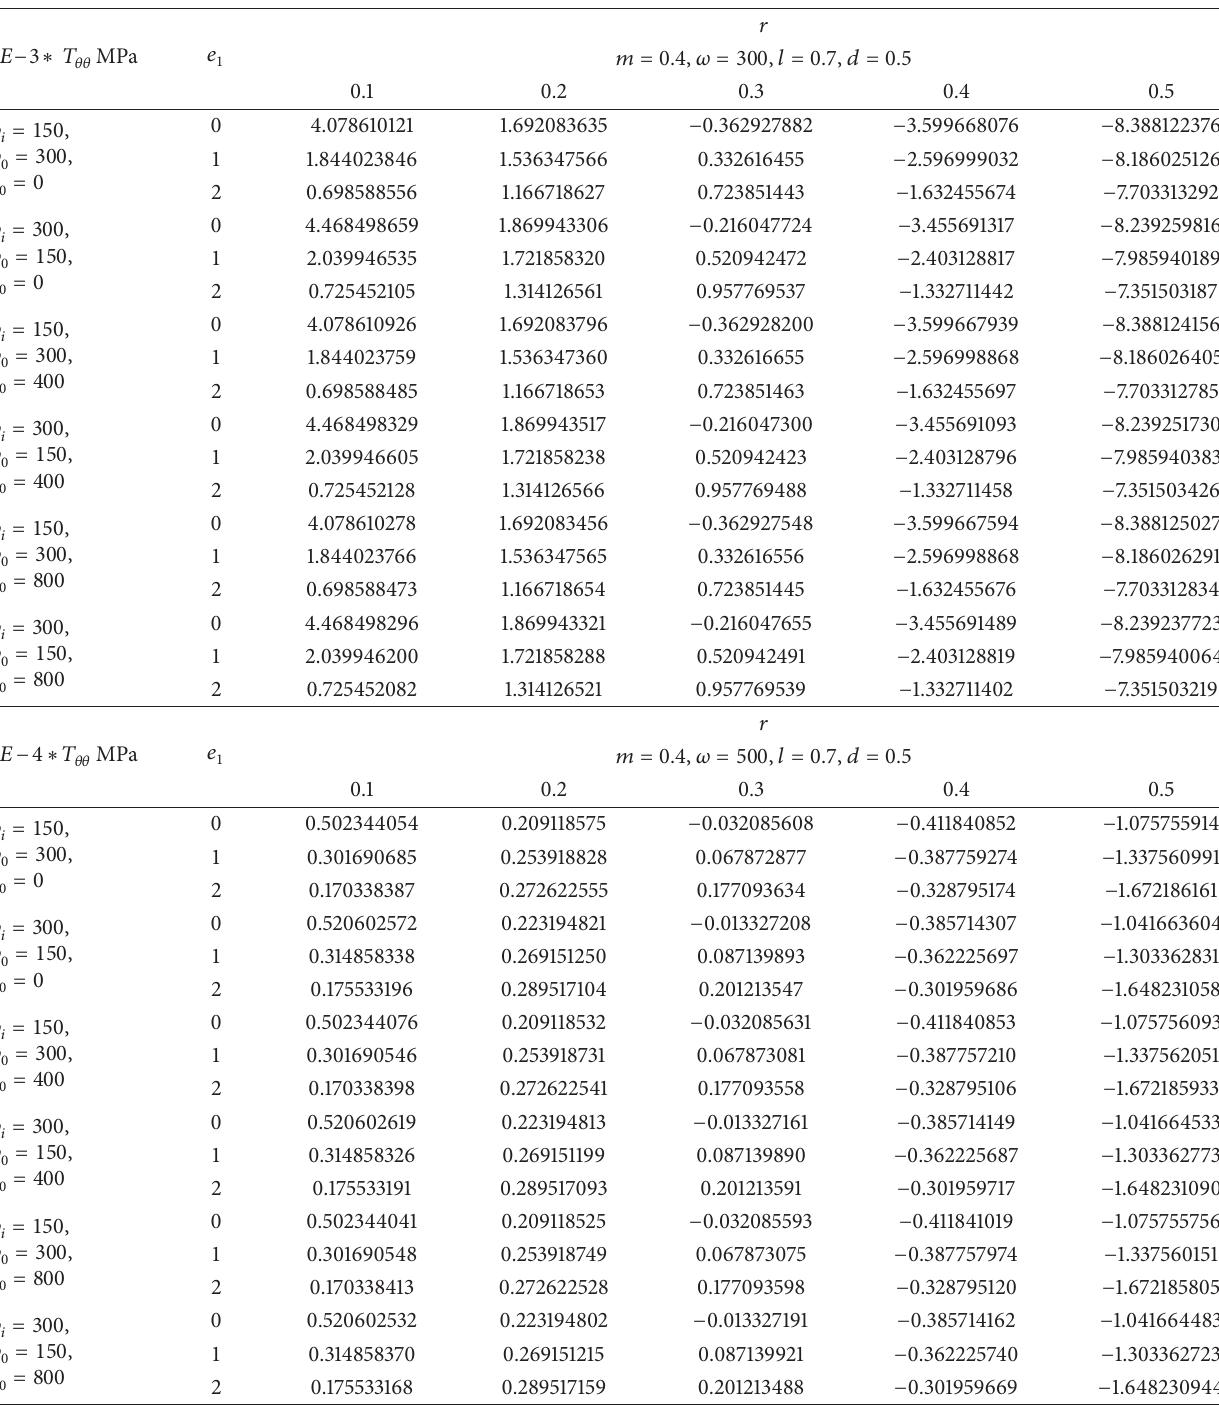
Table 3: Circumferential stresses for rotating cylinder with variable thickness and variable density 𝑙 = 0.7 , 𝑑 = 0.5 , 𝜔 = 300, 500 , strain hardening measure 𝑚 = 0.4 , and different parameters of Young’s modulus under internal and external